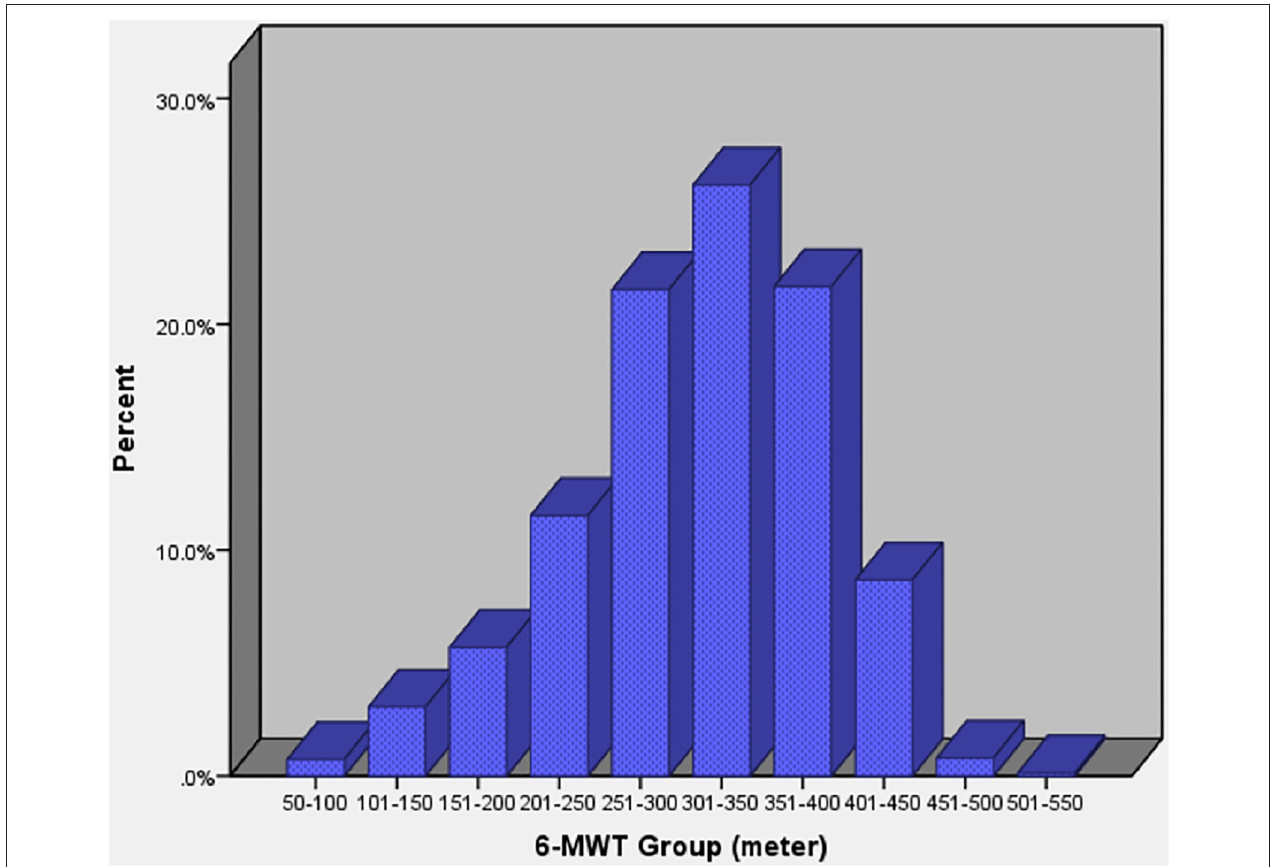
FIGURE 1 | Distribution of 6-MWD of patients after cardiac surgery. 6-MWD, 6-min walk test